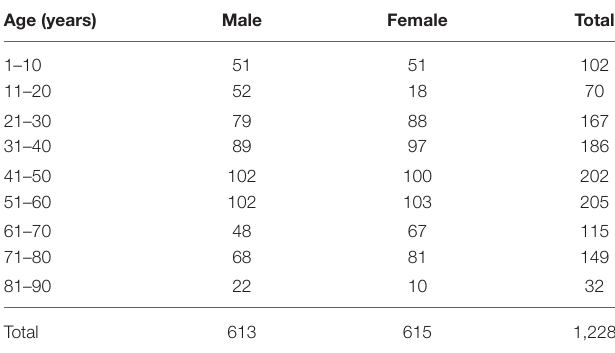
TABLE 1 | Distribution of participants by gender and age